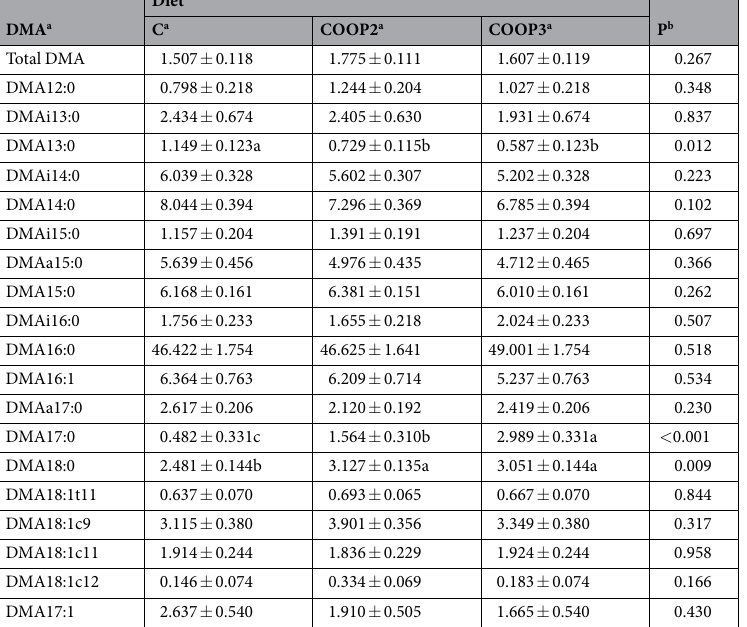
OTUs (based on 97% nucleotide sequence identity). In each sample, a similar number of OTUs was observed, with an average of 1,452 OTUs (ranging from 1,190 to 1,566). Rarefaction curves showed high sequencing cov- erage for all the samples (Supplementary Fig. S1). The α -diversity was calculated from the number of OTUs observed, and the Chao 1 value and Shannon diversity index did not differ significantly among the three groups (Supplementary Fig. S2). Addition of OOPs did not alter the overall microbiota composition, as indicated by the